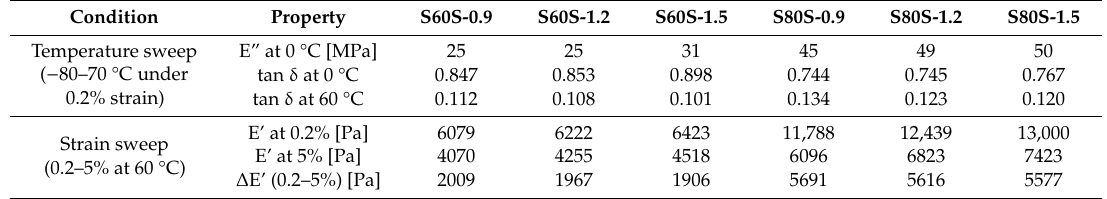
Table 7. Viscoelastic properties of vulcanizates by sulfur